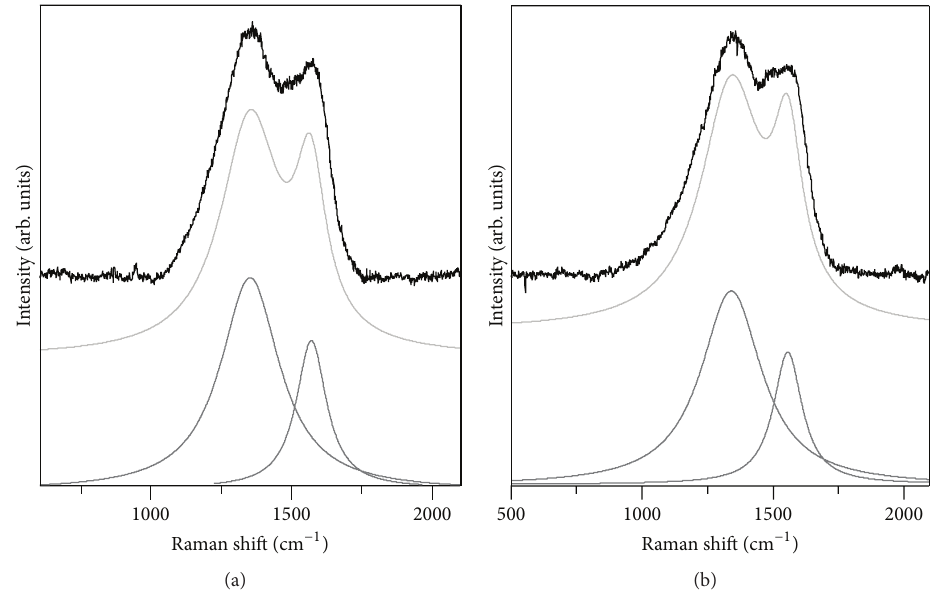
Figure 6: Raman spectra of the S7 (a) and S8 (b) 𝛼 -CN 𝑥 films deposited on silicon and quartz as substrates, respectively.